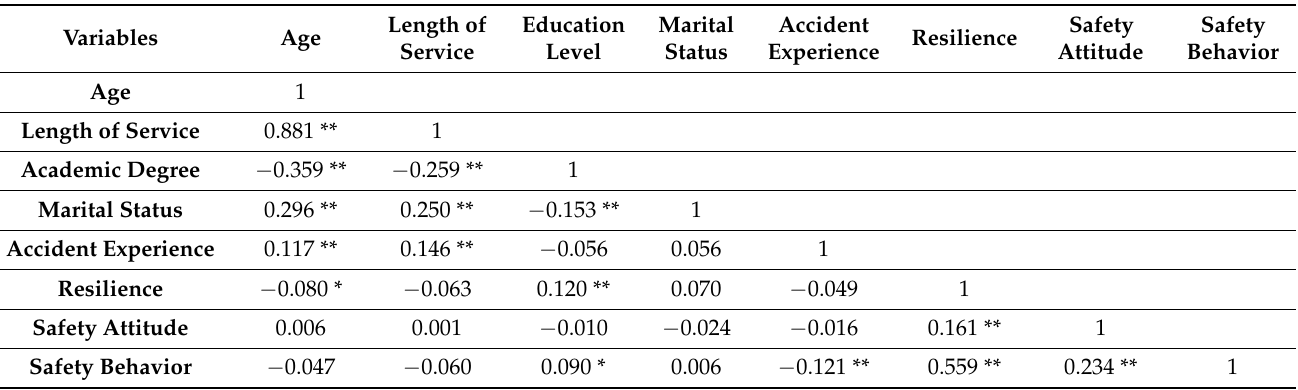
Table 5. Correlation coefficients of the variables.